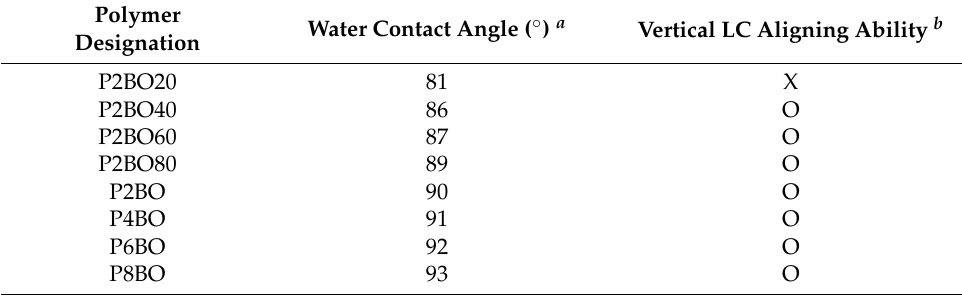
Table 2. Water contact angle and LC alignment behavior of the polymer films.